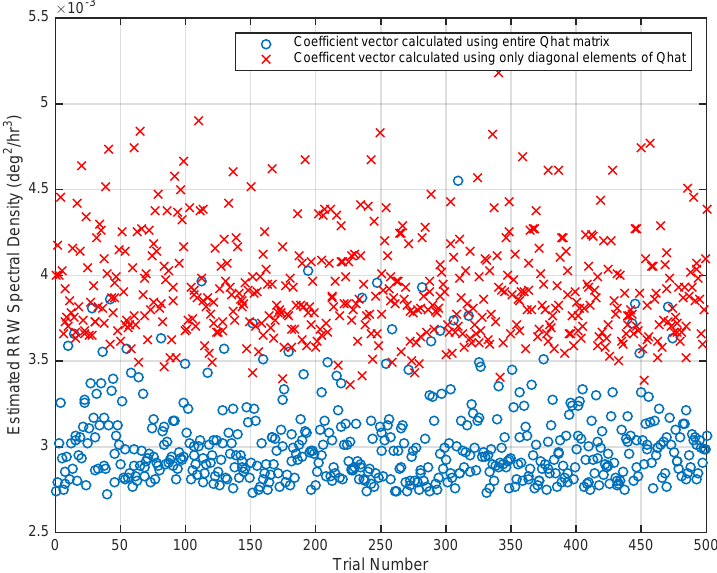
Figure 1. Random drift (RRW) spectral density ˆ Q v for virtual gyros corresponding to coefficient vectors calculated using only the diagonal elements of ˆ Q and using the entire ˆ Q matrix. A virtual gyro created by averaging the gyro signals has an RRW spectral density of 11.5 × 10 − 3 for all trials (see Table